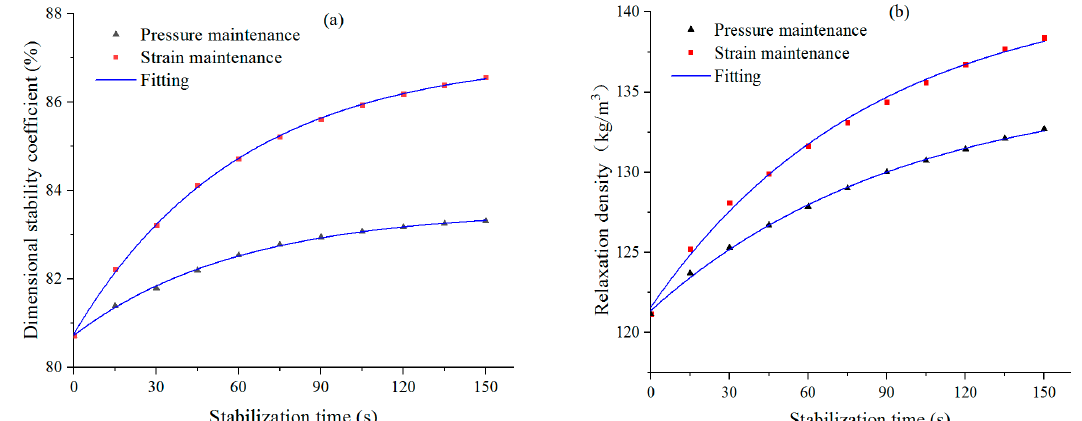
Figure 2. Effects of time on dimensional stability coefficient and relaxation density under different stabilization processes (water content of raw materials of 15%, maximum compression stress of 120.8 kPa, feeding mass of 3 kg). ( a ) Effects of time on dimensional stability coefficient under different stabilization processes; ( b ) Effects of time on relaxation density under different stabilization processes. Table 2. The fitting results of dimensional stability coefficient and relaxation density under different stabilization processes.